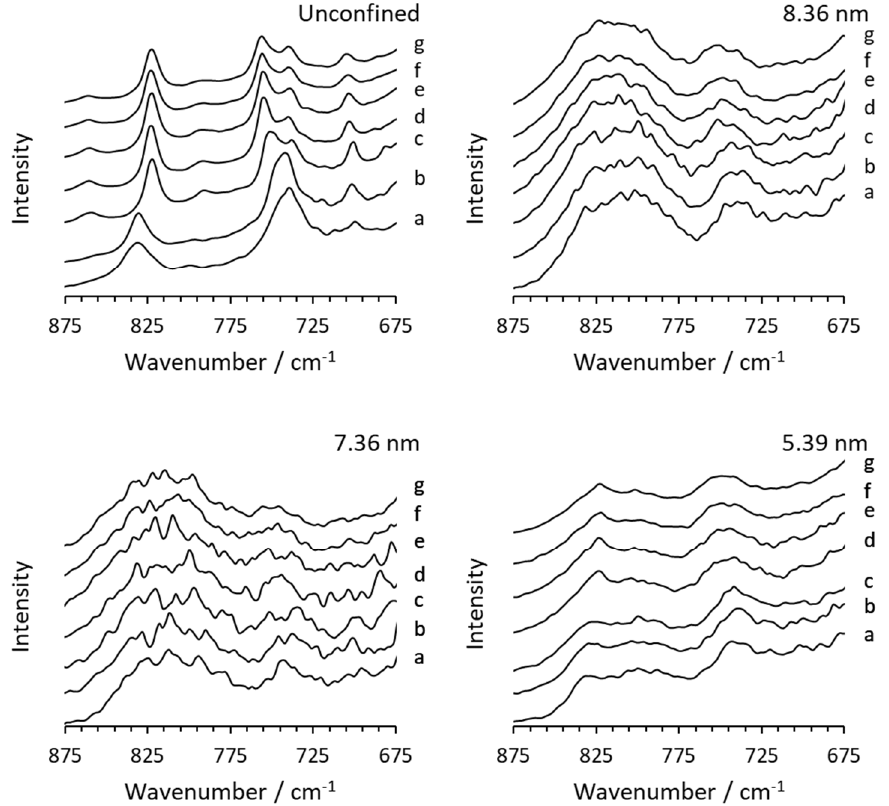
Figure 10. Pressure-dependent mid-IR spectra of unconfined [C 2 mim]FeCl 4 ( upper left ) and [C 2 mim]FeCl 4 confined within 8.36 ( upper right ), 7.36 ( lower left ), and 5.39 nm ( lower right ) mesoporous silicas. Applied pressures are ( a ) ambient, ( b ) 0.4, ( c ) 0.7, ( d ) 1.1, ( e ) 1.5, ( f ) 1.8, and ( g ) 2.5 GPa.